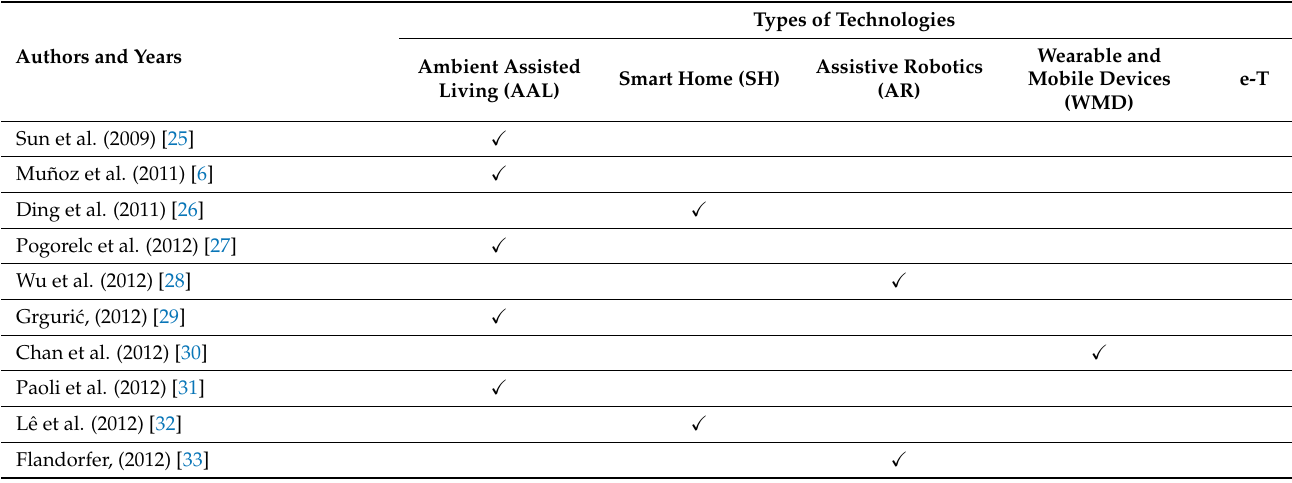
Table 2. The characteristics of the included